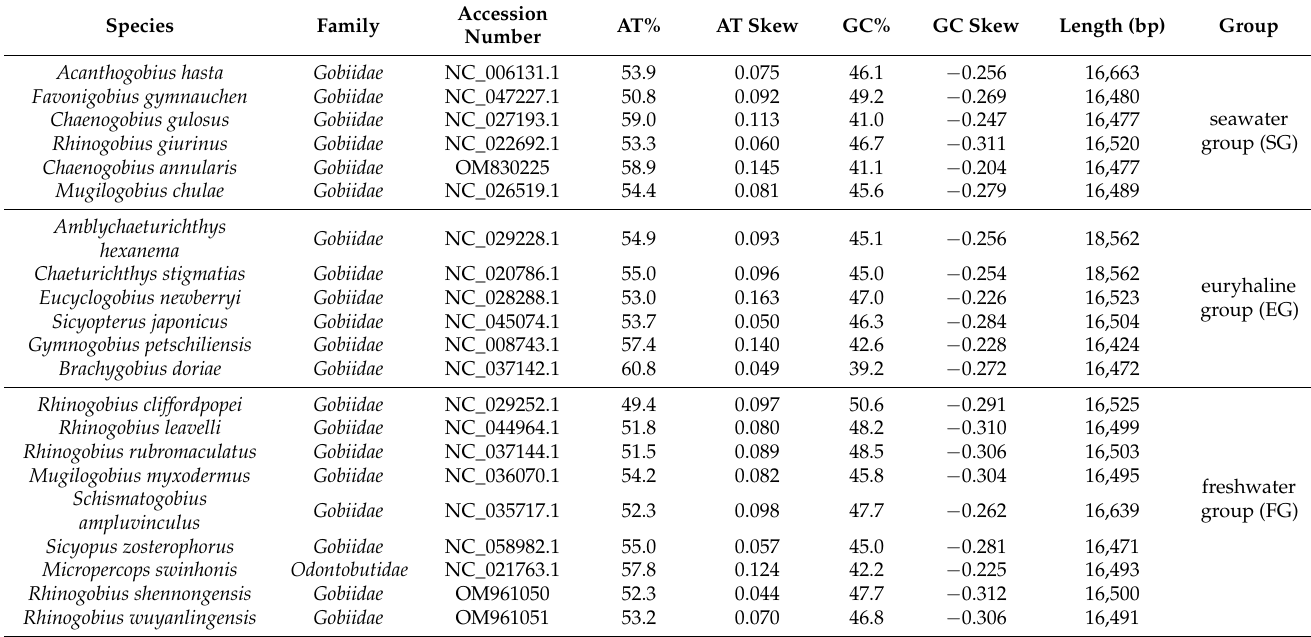
Table 1. The composition skew values were calculated according to the following formulas: AT skew [(A − T)/(A + T)] and GC skew [(G − C)/(G + C)] [28]. Table 1. Mitogenomes of Gobiidae species sequenced to date and their genomic